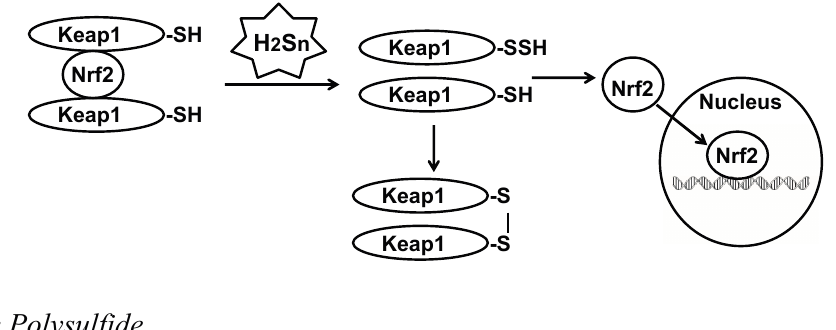
Figure 3. Sulfration of Keap1 by polysulfides release Nrf2 to the nucleus. Nuclear factor erythroid 2-related factor 2 (Nrf2) is sequestered in the cytosol by two molecules of Kelch-like ECH-associated protein 1 (Keap1). When Keap1 is sulfurated by polysulfides, Nrf2 is released and translocates into the nucleus, where it upregulates the transcription of antioxidant